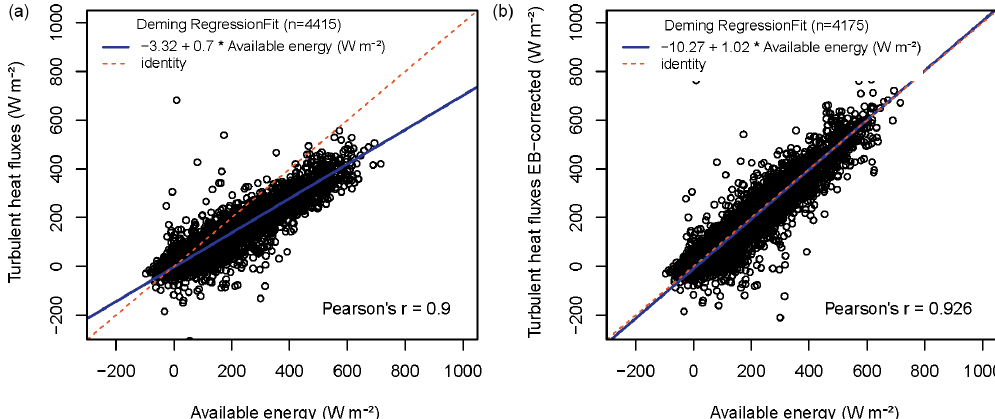
Figure 9. Results the orthogonal regression analysis of the sum of the turbulent heat fluxes ( H + λE) vs. the available energy ( R n − G ) as measured (a) and after application of the EBC correction (b) for the DE-Gwg